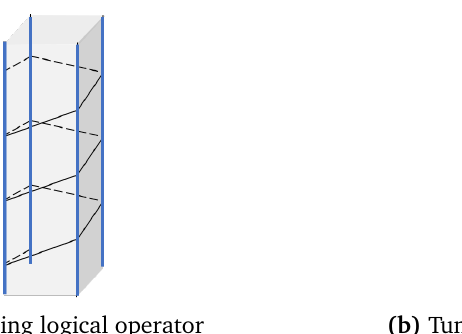
Figure 18: The extra logical operators for the X-cube model with a smooth screw dislocation and smooth outer boundaries. The logical operators are products of X over the blue links. The arrow in (b) shows the tunneling path of a x lineon that creates the logical operator; intermediate states involve more than one